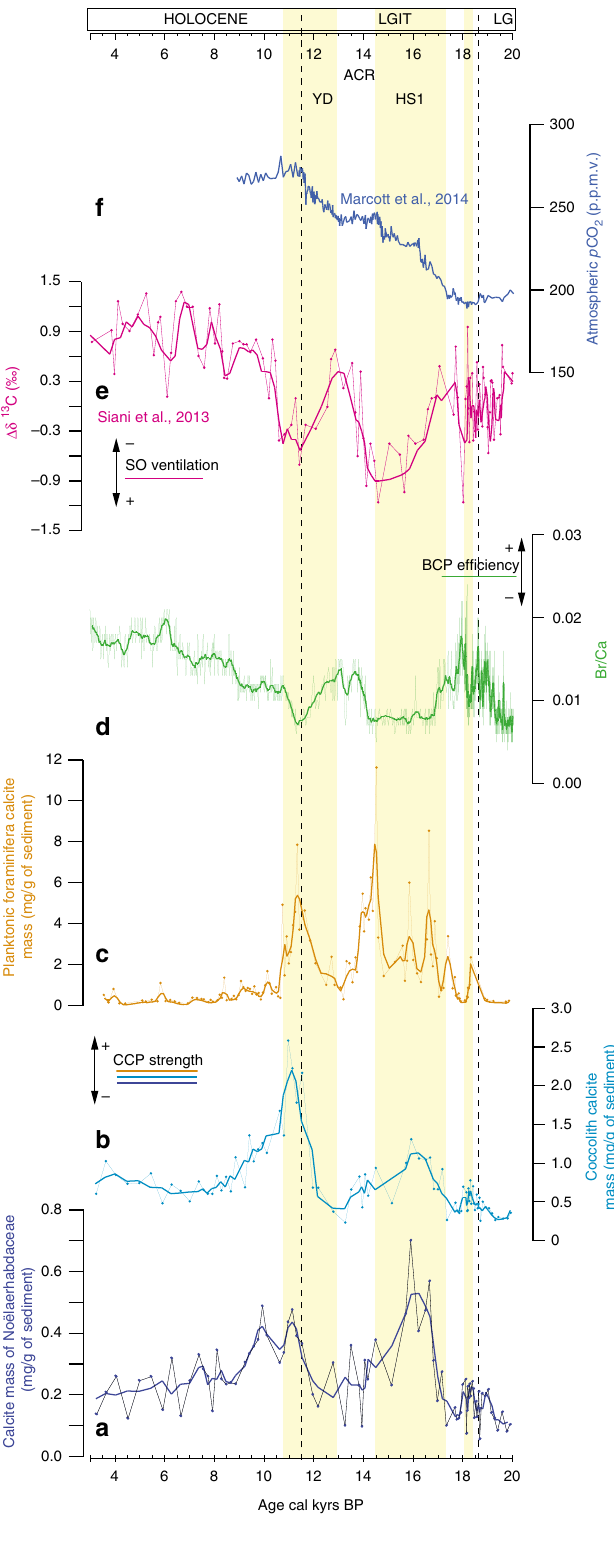
Fig. 4 Subantarctic carbonate counter pump strength and biological pump ef fi ciency coupled with circulation pattern and atmospheric p CO 2 during the last deglaciation. a – c Noëlaerhabdacea, coccolith and planktonic foraminifera calcite masses (mg/g of sediment) at site MD07-3088, with errors bars of ±3% and ±20%, respectively. d Br/Ca ratio as an indicator of POC/PIC rain ratio and thus biological carbon pump ef fi ciency (see Supplementary Fig. 3). e Δ δ 13 C = δ 13 C G. bulloides – δ 13 C C. wuellerstor fi 14 . f Atmospheric p CO 2 from WDC 56 . Smoothed curves (thick lines of a – c , e and d ) use three and eleven-point moving averages respectively. LG and LGIT are for Late Glacial and Last Glacial-Interglacial Transition, respectively. Yellow shading marks periods of reinvigorated SO upwelling (associated with enhanced sea surface fertility conditions and higher [CO 2aq ]) during the last deglaciation, in conjunction to higher CCP strength and subdued biological pump ef fi ciency, at times of increased atmospheric p CO